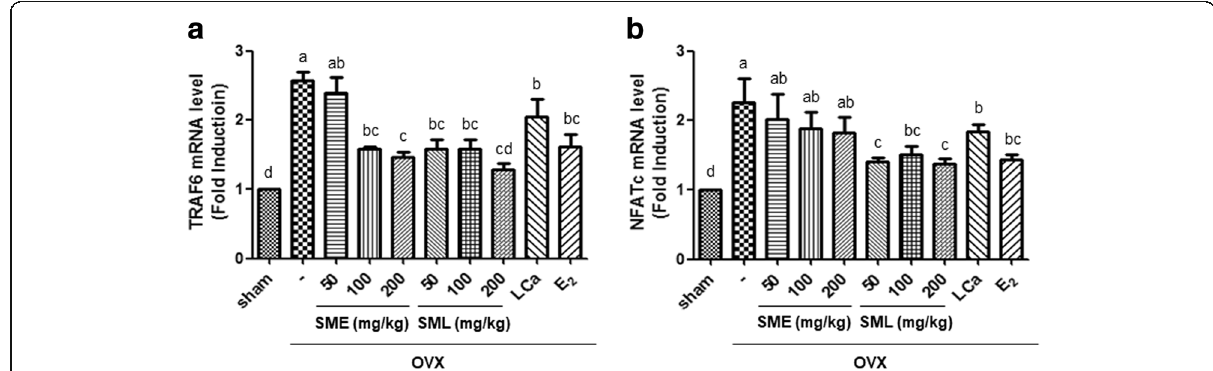
Fig. 6 Effects of SML on the expression of TRAF6 and NFATc1 in OVX mice. RNA was extracted from the bone marrow cells of OVX mice, and a the mRNA levels of TRAF6 and b NFATc1 were assessed by real-time PCR assay. β -actin was considered an internal control. Data are the mean ± S.E.M. of three independent experiments ( n = 7) for all groups. Means unlike letters in a column with differ significantly ( p <